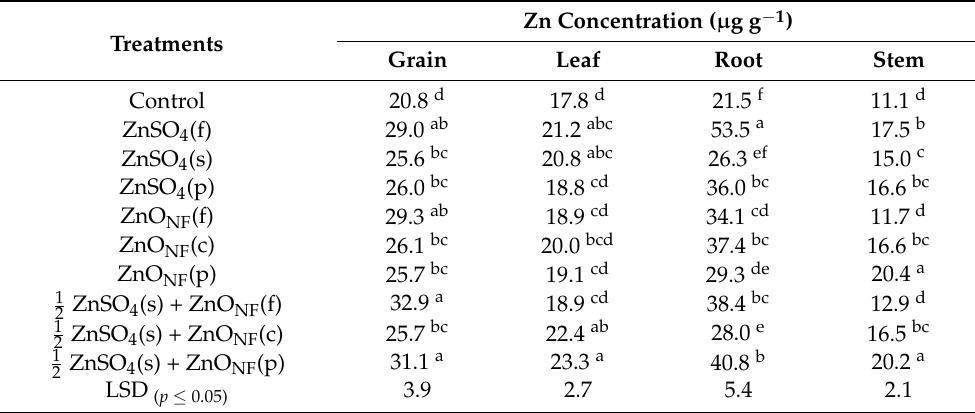
Table 3. Zn concentration in leaf, stem, root, and grain of wheat as influenced by different modes and sources of Zn